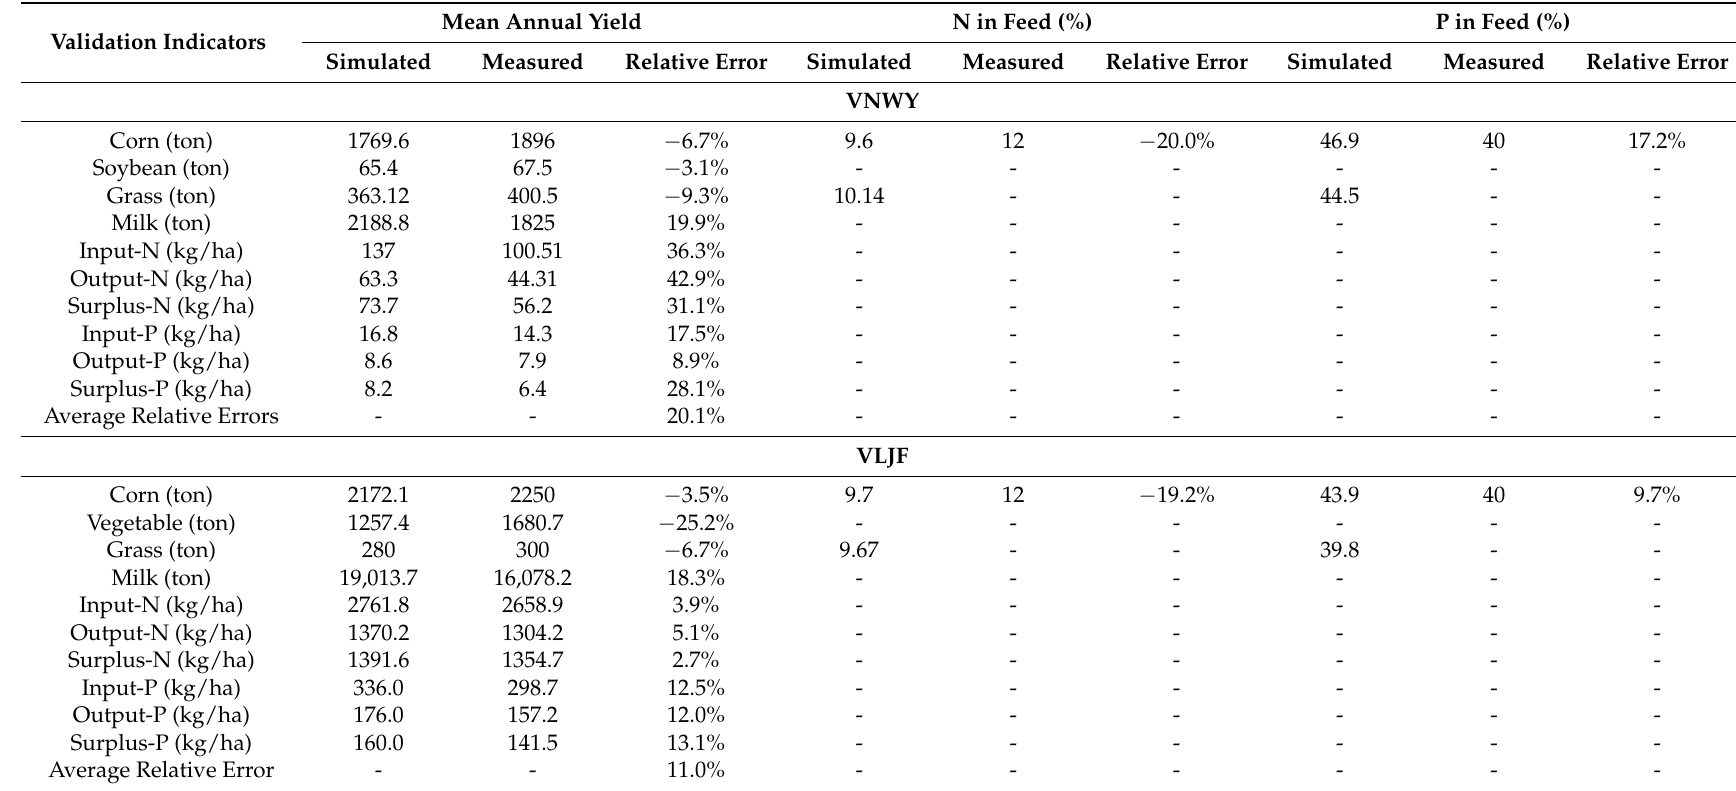
Table 4. Validation of the results from IFSM